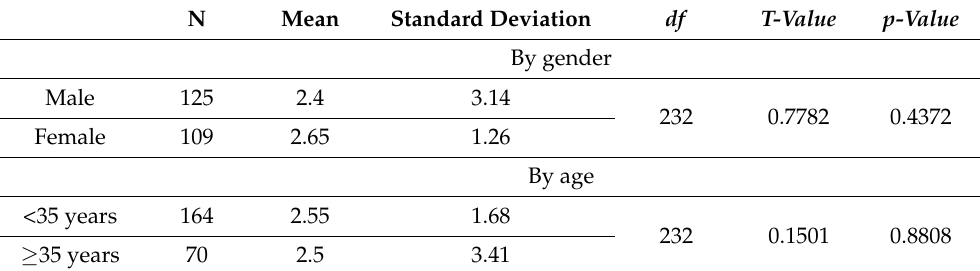
Table 4. Difference in opinions among participants groups in relation to eHealth adoption reasons. N